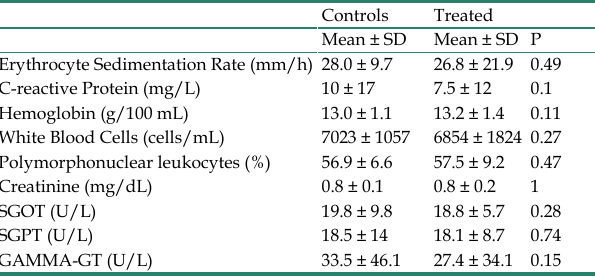
Table 3. Serum laboratory values at 6 months after index surgery. Controls